Question: Identify the chart type used in this figure.
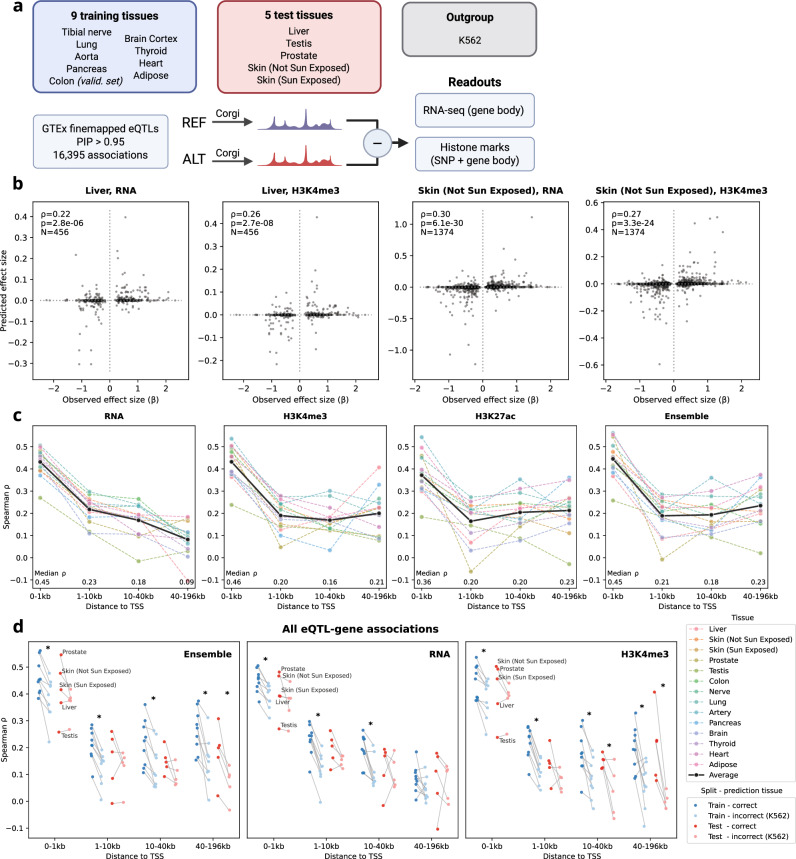
Answer: line